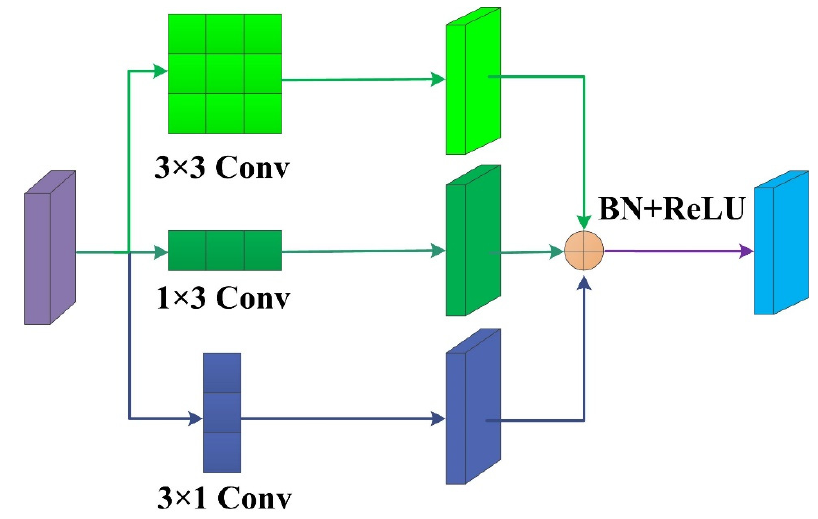
Figure 6. Structure of the ACB.